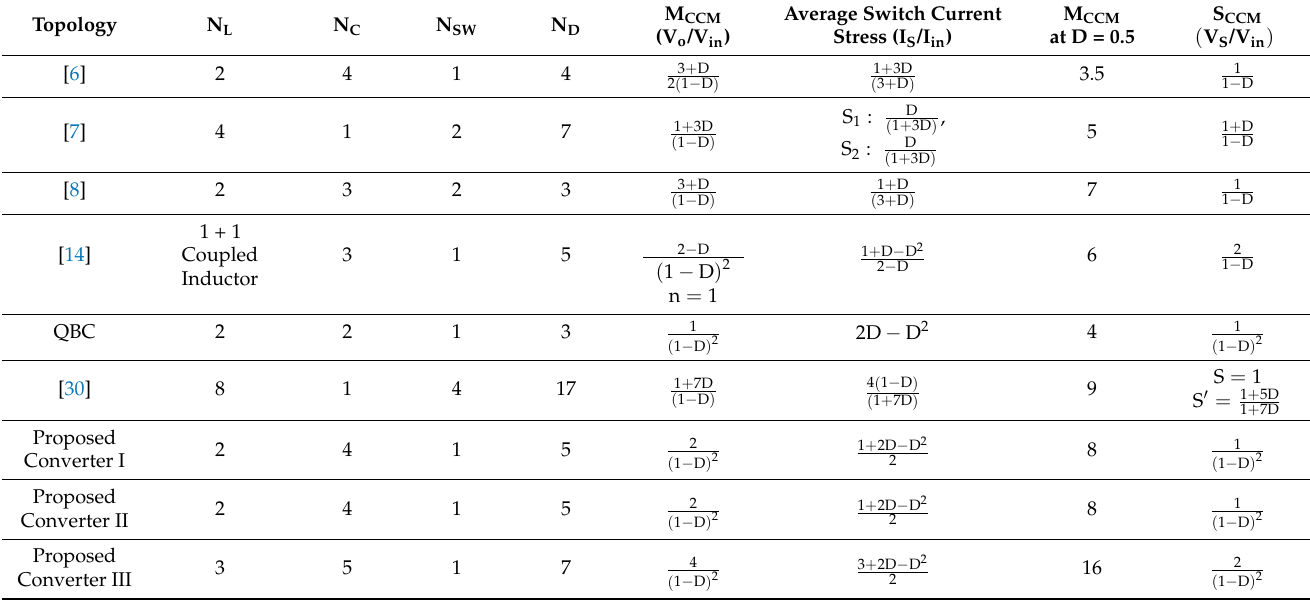
Table 2. Comparison with other